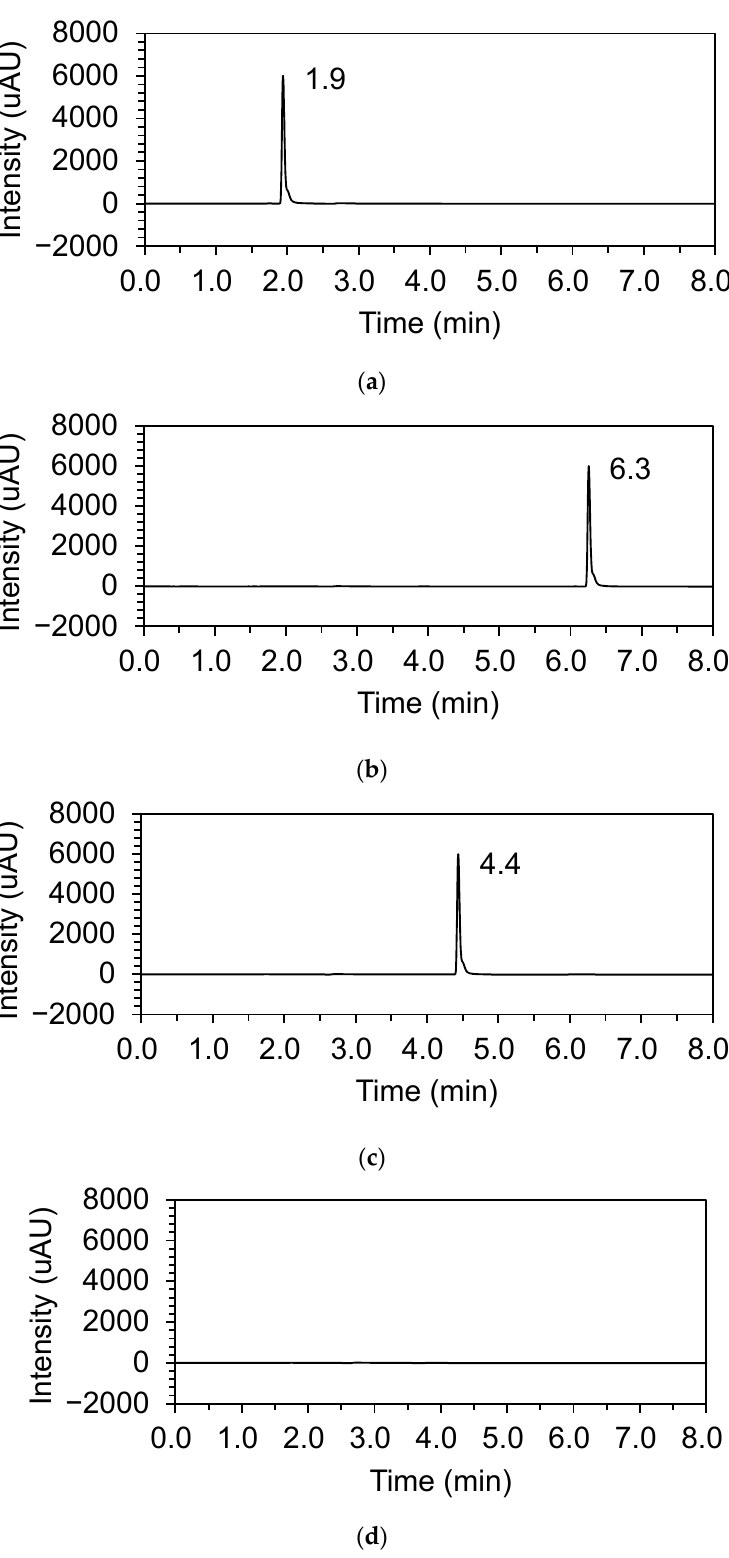
Figure 2. Chromatograms of 10 µg/mL of baclofen ( a ), impurity A ( b ), impurity B ( c ), and the solvent only ( d ).